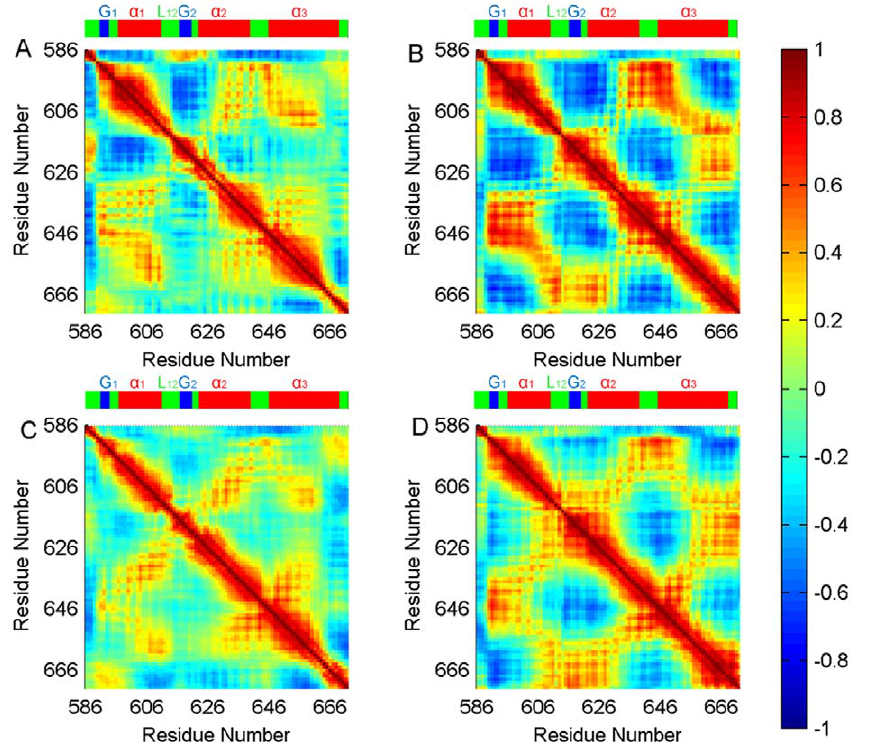
Figure 4. Cross correlations of fluctuations of KIX from different simulations. The cross-correlation maps of KIX from the simulations of: (A) KIX-only, (B) KIX:MLL, (C) c-Myb:KIX, (D) c-Myb:KIX:MLL. The color scale is represented on the right ranging from red to blue: highly positive correlations are in red, highly negative correlations are in blue. Colors in between relate to the scale among these extremes. The numbers on the axes refer to residue positions. The figure illustrates the strong coupling between the Ala630- Ser642 region and the His592-Pro617 region; Lys606-Leu628 region with His651-Glu666. The cross-correlations of the motions between these regions imply that they play an important role in the propogation of the allosteric effect upon MLL binding to KIX. The color bar on the top of each map stands for the secondary structure ( a -helix: Red, Loop: Green, 3 10 - helix: Blue).